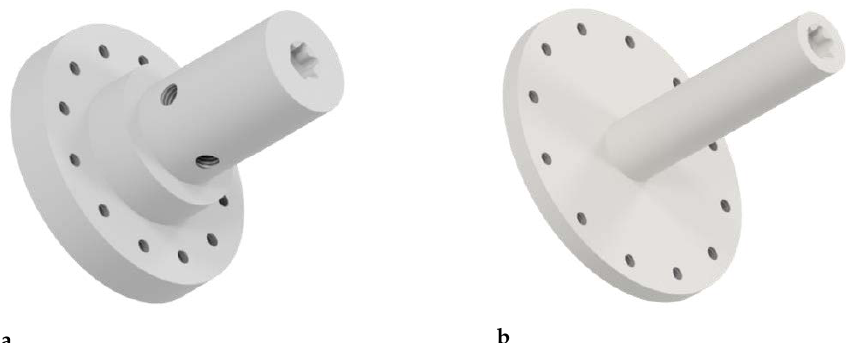
Figure 4. Dummy masses for BorgWarner BV35 turbocharger wheels, with integrated holes for balancing masses and front faced torx coupling: ( a ) TDM; ( b )